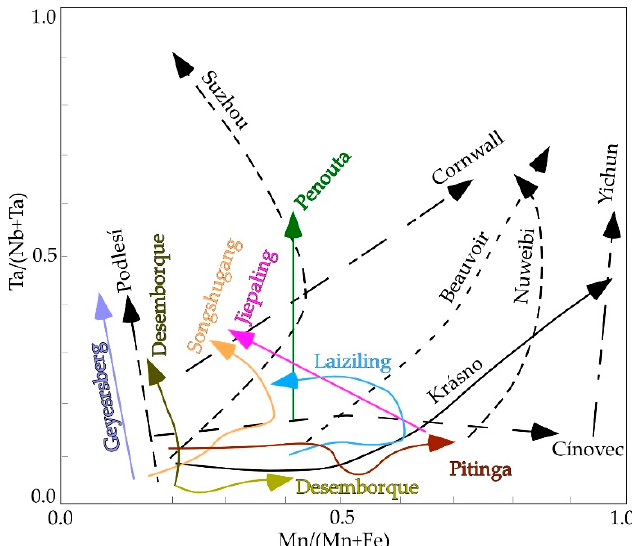
Figure 9. Compositional trends of columbite in F- and Li-rich rare-metal granitic systems and associated greisens worldwide after Reference [40]. Desemborque, South-Southern Brazil (this work);